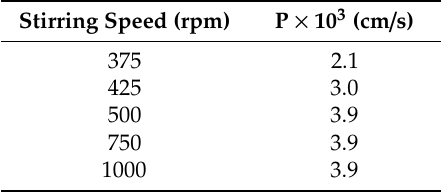
Table 2. Dependence of gold(III) permeabilities values on the stirring speed of the feed phase. Stirring Speed (rpm)